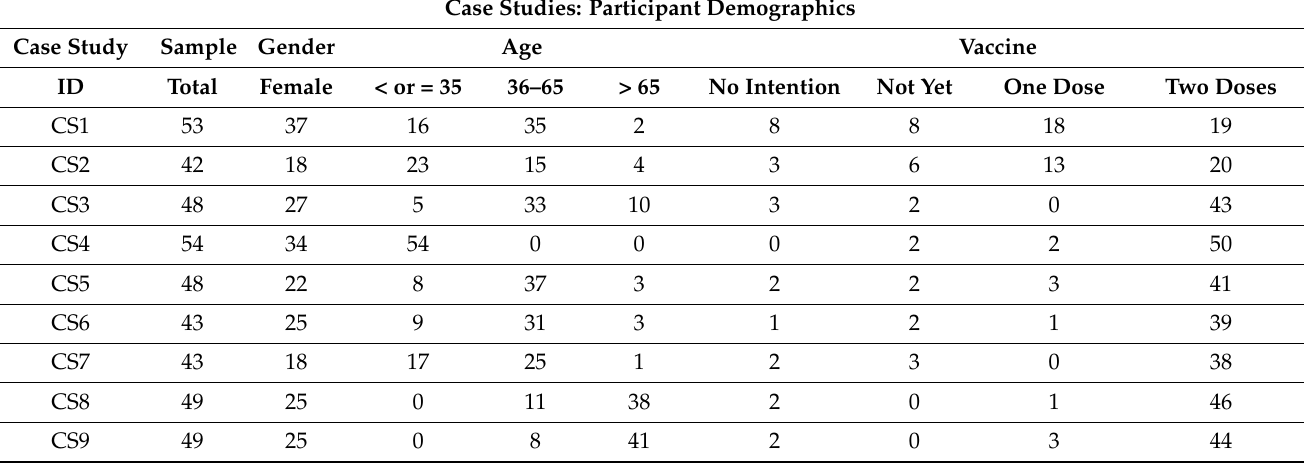
Table A4. Table illustrating the frequencies of the sample size, gender, age, and vaccination status of the sample for each single case study (CS1–CS9). Own processing.